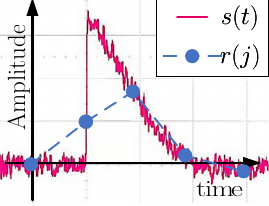
Figure 5. SNSPD response pulse waveform. s ( t ) denotes the time-domain model of the waveform. r ( j ) indicates the discrete signal. Algorithm 1 Waveform matched PPM symbol decision